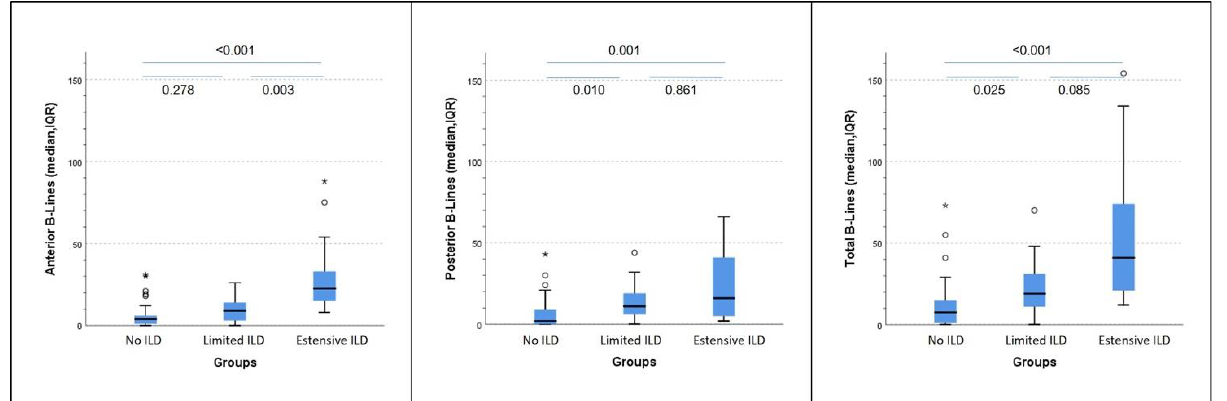
Figure 2. Distribution of anterior, posterior and total B-lines among the patients with absent, limited and extensive interstitial lung disease. ILD = interstitial lung disease. Statistical significance is set for p < 0.05. ° represent mild outliers, while * represent extreme outliers, in relation the distribution of B lines within the group.